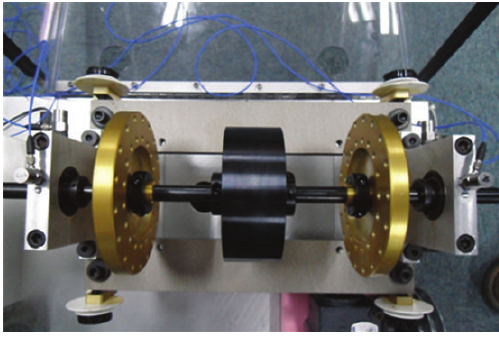
Figure 4: Accelerometer sensors